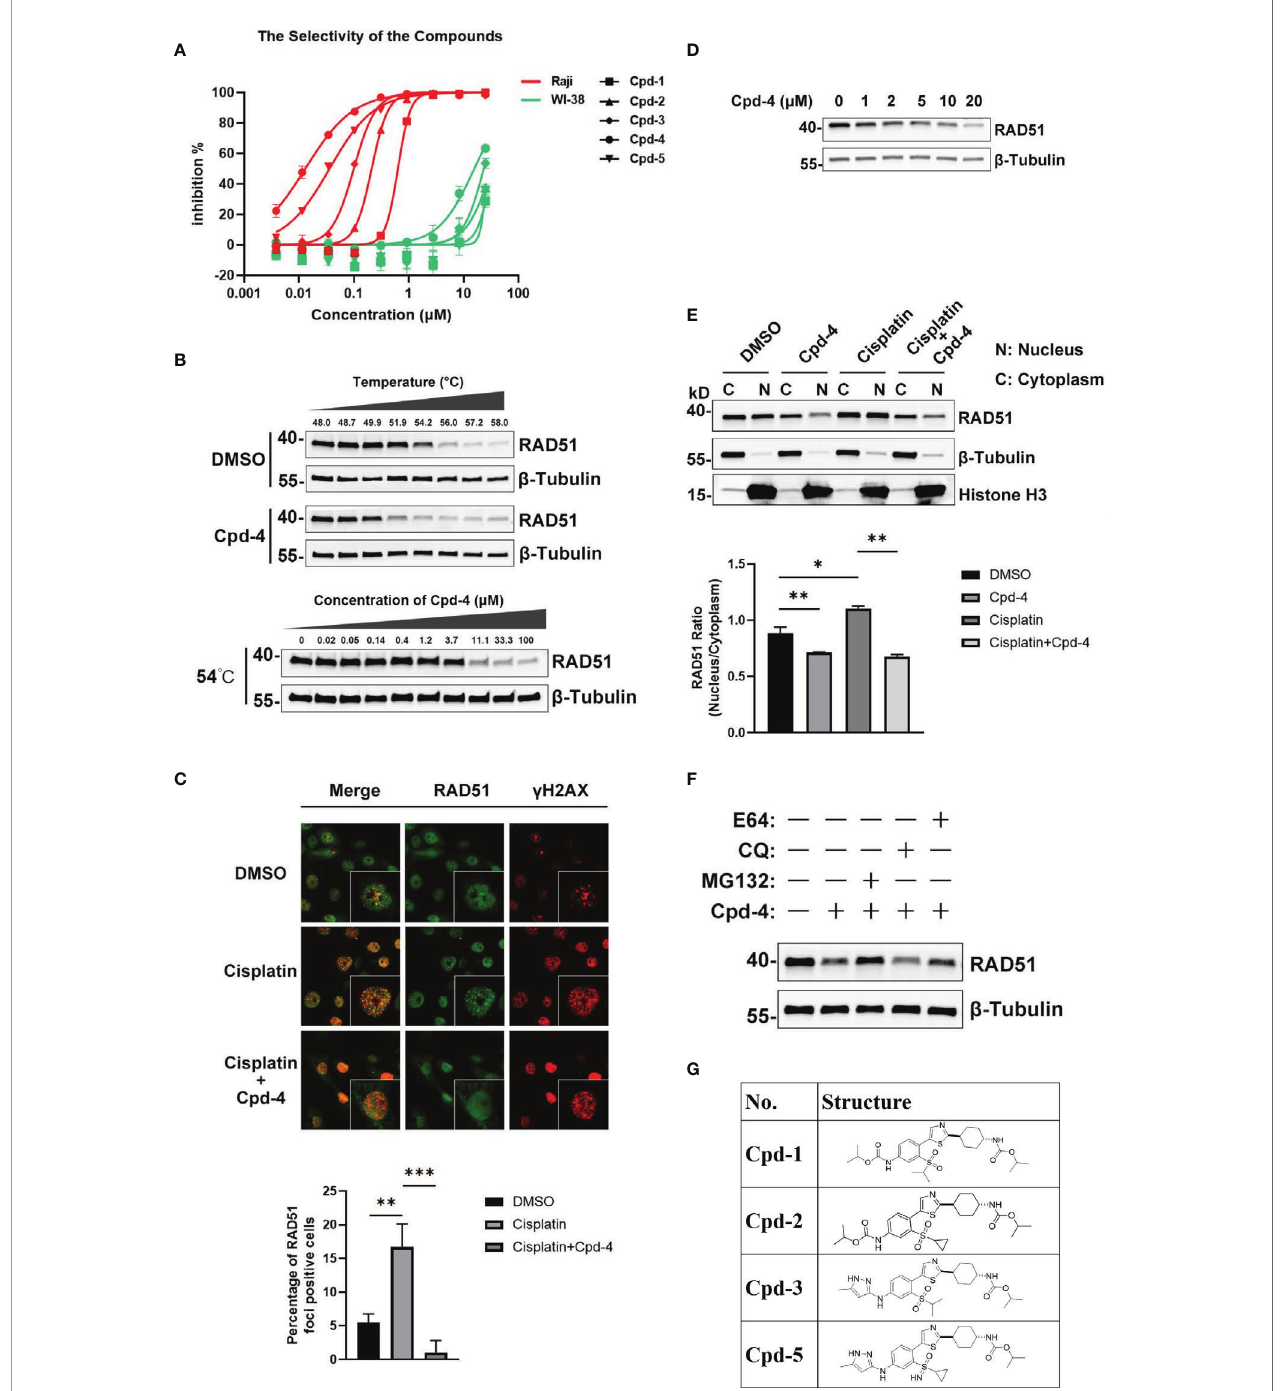
FIGURE 2 | Discovery and mechanism of action of a novel class of RAD51 inhibitors. (A) Representative dose response curve of a series of RAD51 inhibitors on Raji and WI-38 cell line generated in GraphPad Prism. (B) Comparison of thermo stability of endogenous RAD51 protein with or without the treatment of compounds. b -Tubulin served as the negative control. In the top panel, Z138 cells were treated with 20 m M Cpd-4. (C) Image analysis of DNA damage and repair marker upon the compound treatment. HCC1937 cells were treated with DMSO (upper and middle panels) or Cpd-4 (10 m M, lower panel) for 2 days, then cells were exposed to cisplatin (10 m M) for 2 h (middle and lower panels) and stained 5 h later. Quanti fi cation shows fraction of cells with ≥ 10 RAD51 foci. (D) Western blot analysis of endogenous RAD51 protein level in HCC-1937 cells after the treatment of compounds for 24 h. (E) Subcellular fraction of RAD51 protein in HCC-1937 cells were separated by using the NE-PER Nuclear Cytoplasmic Extraction Reagent Kit (Pierce) and analyzed by western blot. b -Tubulin and histone H3 were used as the cytoplasmic and nuclear markers, respectively. (F) Compounds treatment induced RAD51 protein degradation can be blocked by proteasome inhibitor (MG132) but not lysosome inhibitor (CQ or E64). All data represent mean ± SD based on at least three biological repeats. (G) Structures of representative compounds. *, P<0.05; **, P <0.01; ***, P